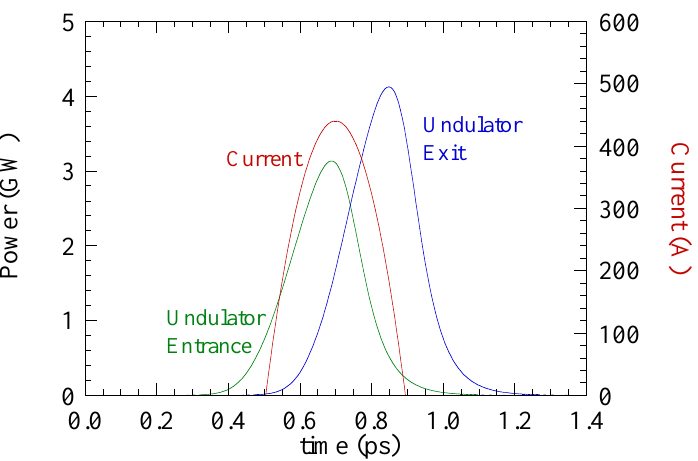
Figure 9. Temporal profiles of the power in the optical pulse after 100 passes at the undulator entrance (green) and exit (blue), as well as the current in the electron bunch (right axis, red) for the IR upgrade experiment. The cavity length is L cav = 32.041946079 m and other parameters, as described in the